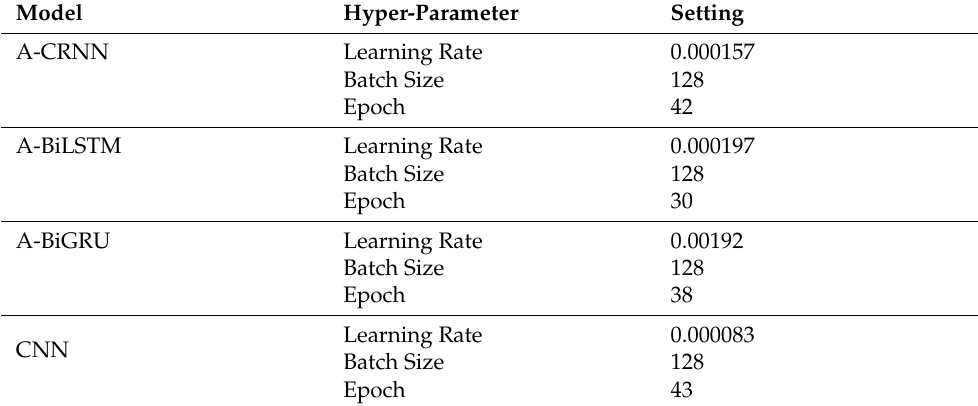
Table 13. Optimized hyper-parameter settings with respect to